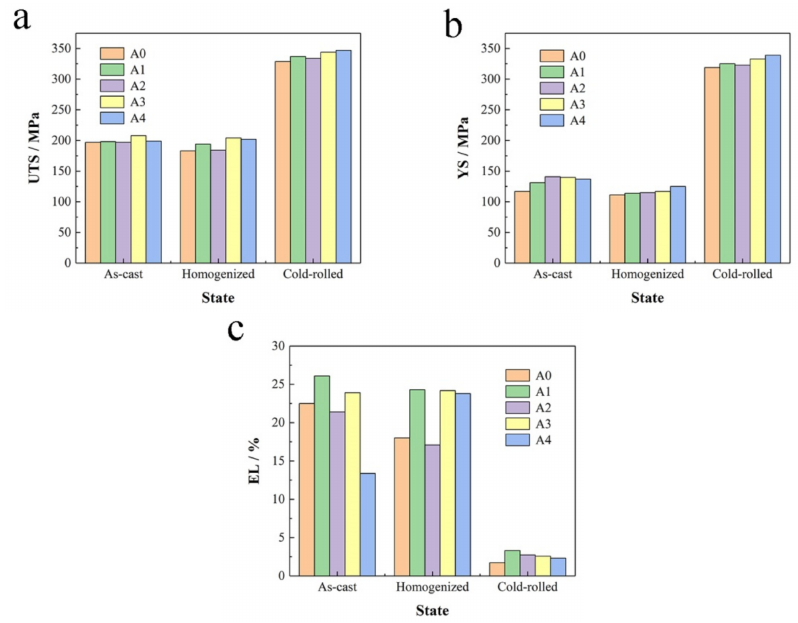
Figure 6. Mechanical properties of 5052 aluminum alloys tested via tensile testing machine: ( a ) UTS; ( b ) YS and ( c ) EL.